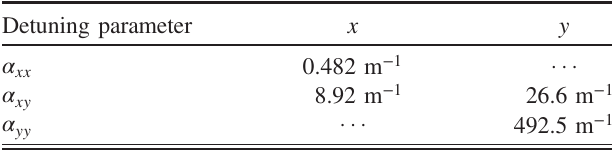
TABLE IV. Detuning parameters needed for Landau damping. Detuning parameter